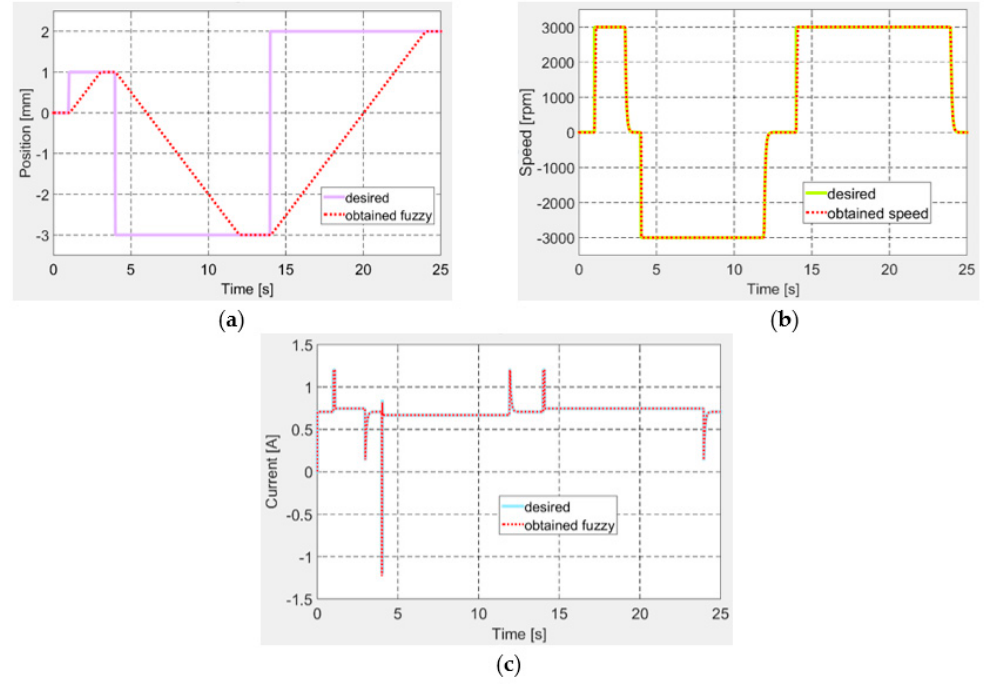
Figure 14. Control for successive steps signal as desired position: ( a ) position, ( b ) speed, and ( c ) current.